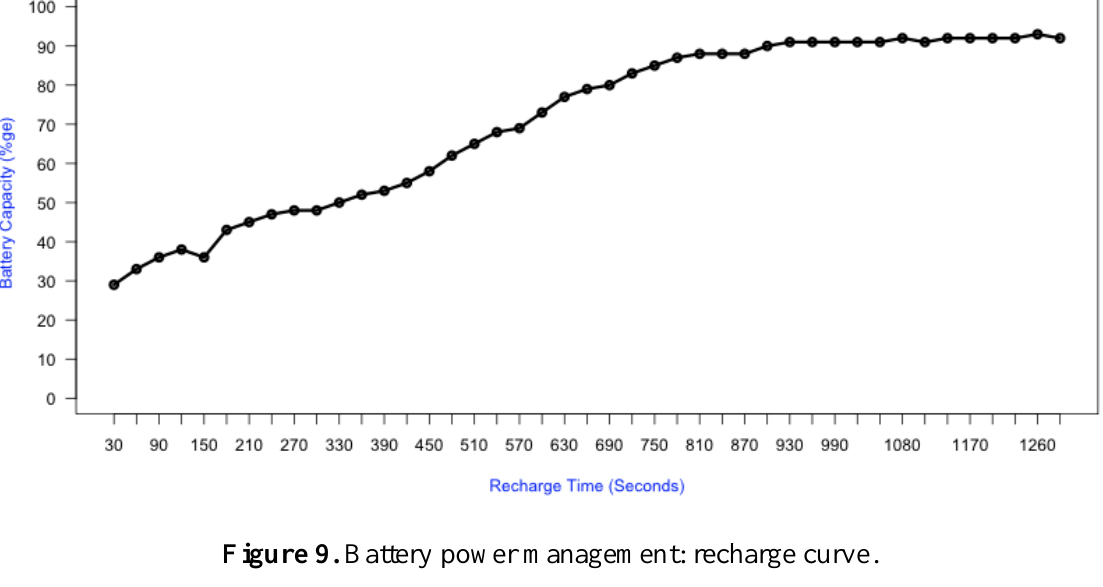
Figure 9. Battery power management: recharge curve.